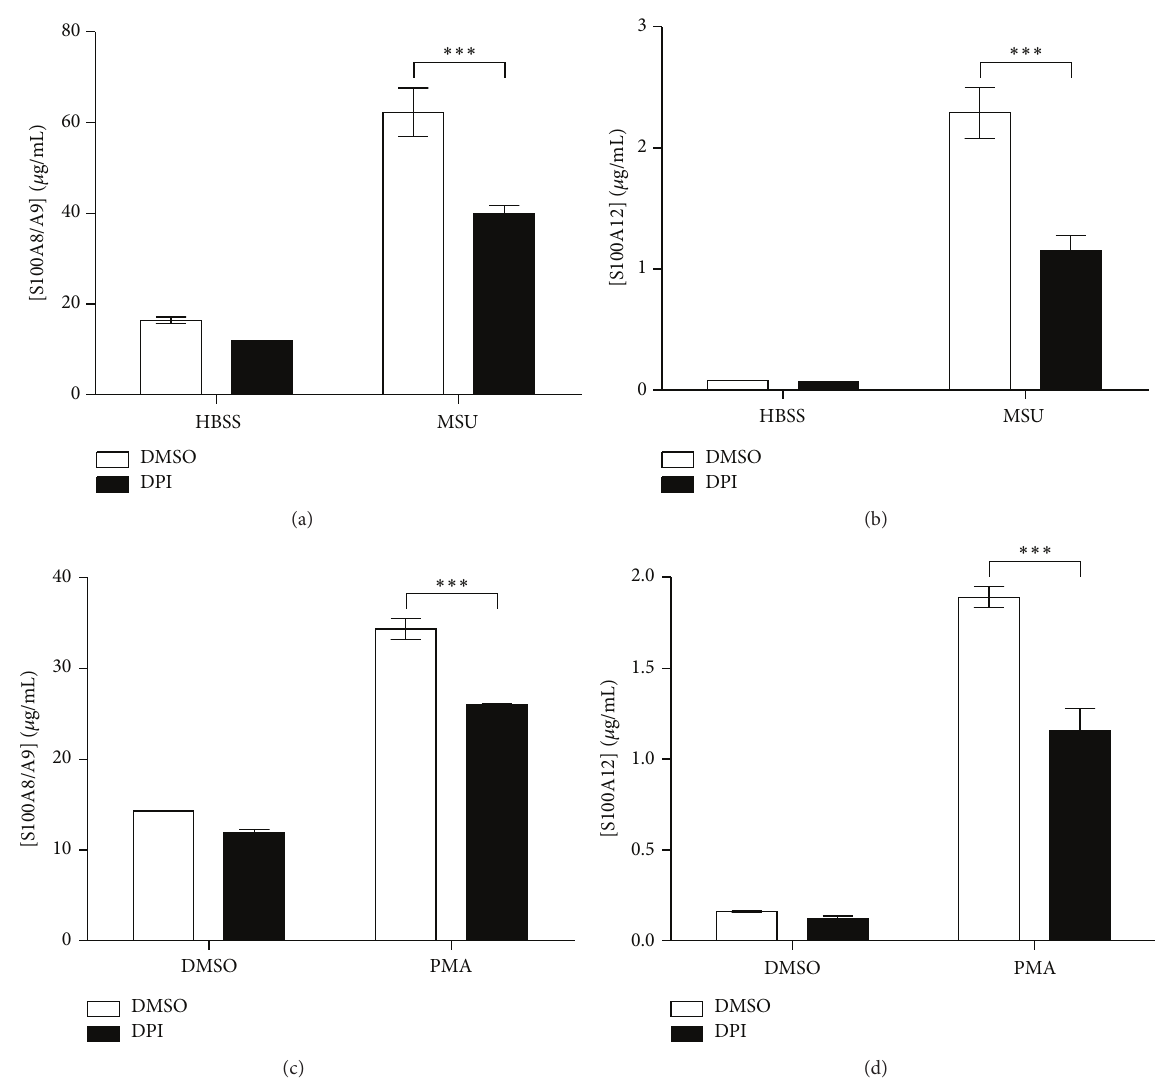
Figure 5: Inhibition of calgranulin secretion by DPI. Neutrophils were preincubated with the NADPH oxidase inhibitor DPI (10 𝜇 M) and then stimulated with 1.5mg/mL MSU crystals or 10nM PMA for 60 minutes. (a and b) S100A8/A9 and (c and d) S100A12 in the supernatants were then quantified by ELISA. Results represent the means ± SEM of 5 donors. ∗∗∗ 𝑃 < 0.001